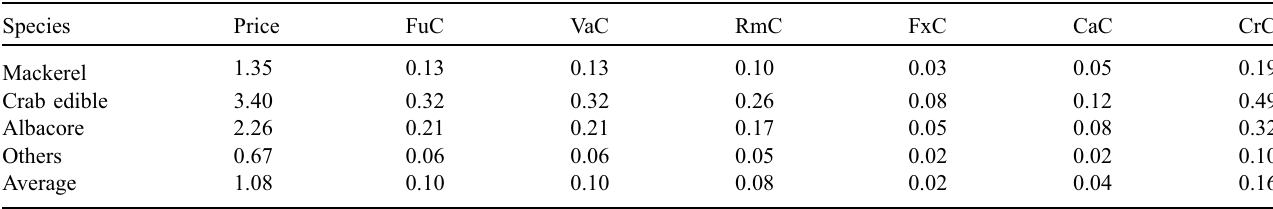
Table A.8. Price and cost structure (fuel costs (FuC), other variable costs (VaC), crew costs (CrC), repair and maintenance costs (RmC), fi xed costs (FxC), capital costs (CaC)) of main species exploited in the OTH fi shery (others) by the polyvalent general þ 18m fl eet segment in 2019.